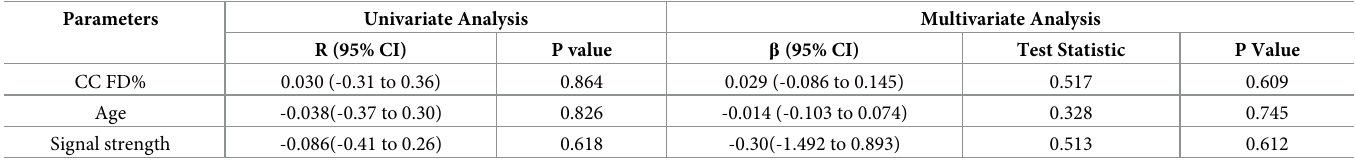
Table 3. Univariate and multivariate analyses for the relationship between the systemic severity score and